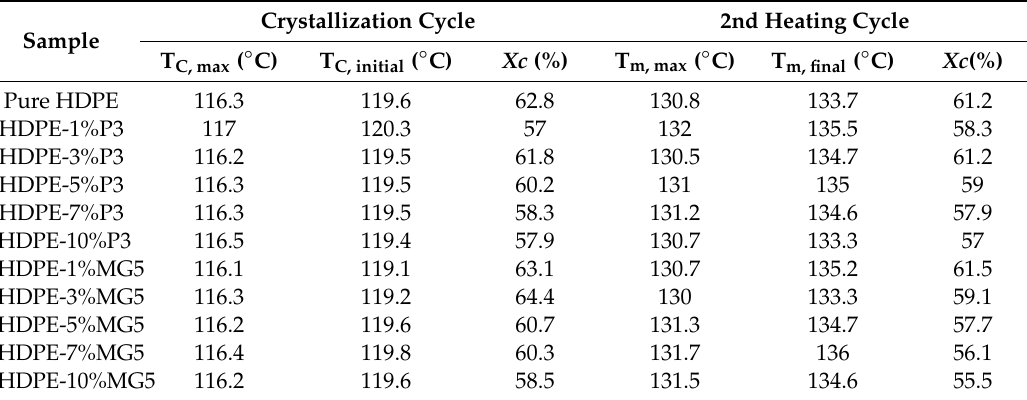
Figure 8. DSC curves from the second heating cycles of ( a ) HDPE-P3 composites and ( b ) HDPE-MG5 composites. Table 3. Melting and crystallization characteristics of HDPE and the prepared PNCs.